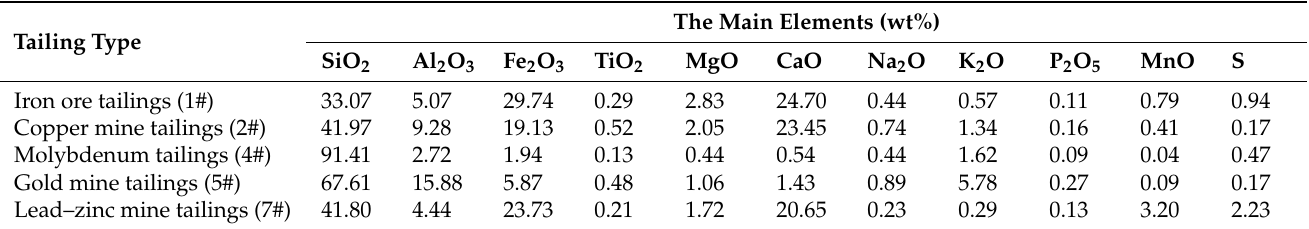
Figure 2. Photomicrographs of different tailings in typical mining areas of Tibet Autonomous Region. Table 4. Characteristics of main elements of different tailings in typical mining areas of Tibet Autonomous